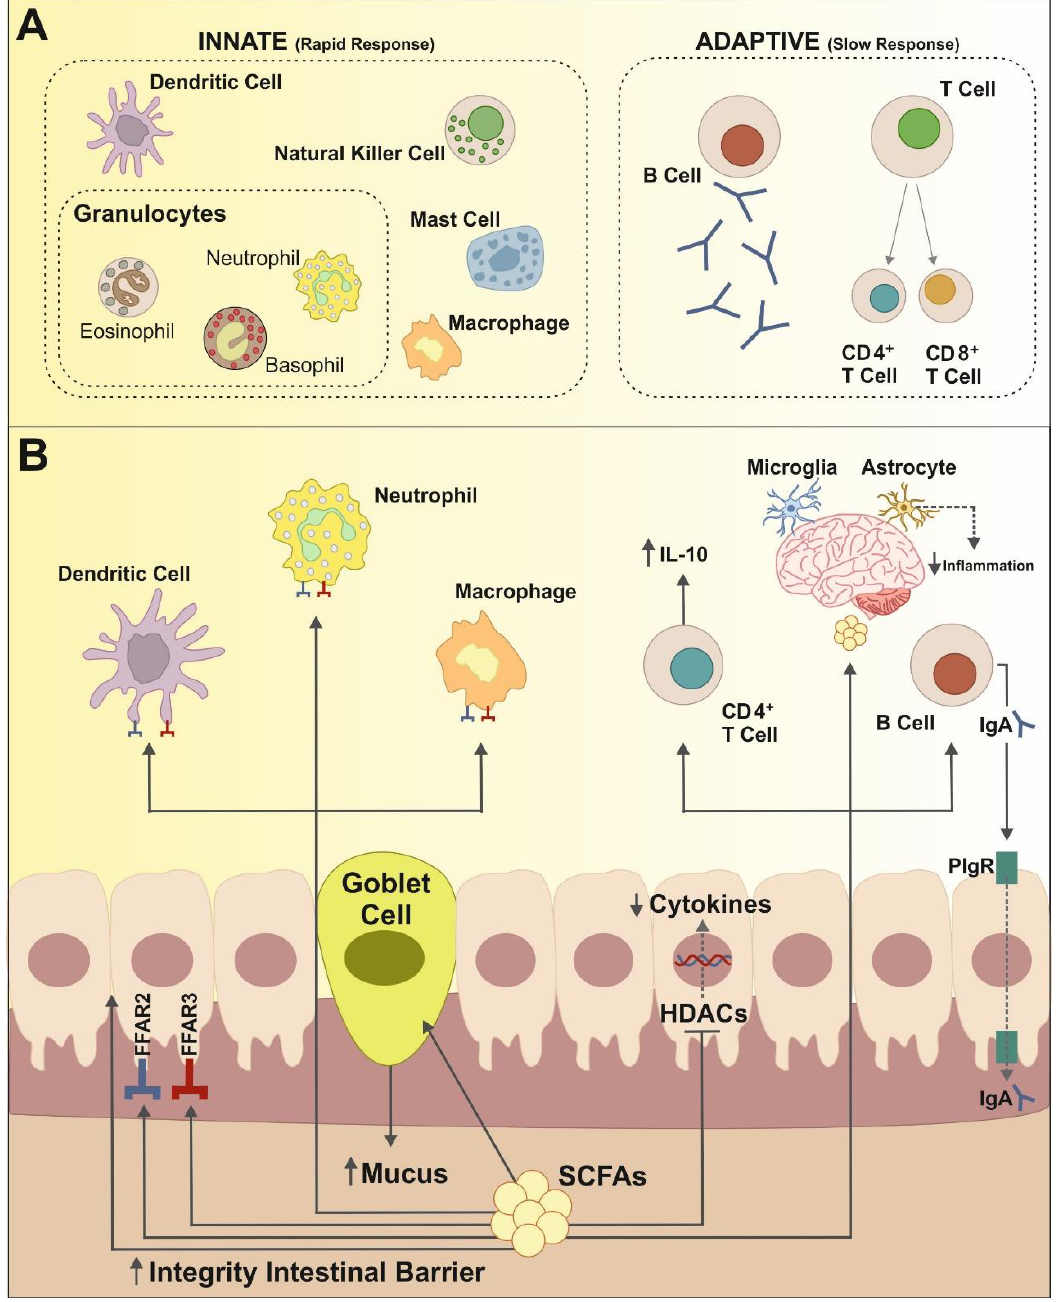
Figure 1. Relationships between the innate and the adaptive immune systems and gut microbiota. ( A ) The innate immune response is a very fast, pathogen-non-specific, first line of defense mechanism. It is mainly composed of macrophages, dendritic and natural killer cells, as well as different forms of granulocytes. The adaptive immune system is highly specific to a particular pathogen and is formed by B and T cells lymphocytes. ( B ) The gut microbiota is in close interaction with both the innate and the adaptive immune system. This interaction is frequently driven by SCFAs, which modulate local as well as systemic immune response. SCFAs can bind to G-protein-coupled receptors as FFAR2 and FFAR3 present on the surface of gut epithelial cells and immune cells including dendritic cells, macrophages and neutrophils, and are therefore important regulators of inflammatory response. SCFAs also promote the activation of B cells and the development of Treg CD4+T cells—for example, increasing secretion of IL-10 with important anti-inflammatory effects. Suppression of inflammatory factors like cytokines is further achieved by the inhibition of histone deacetylases (HDACs) activity. Finally, SCFAs have been shown to modulate immune inflammation responses in extraintestinal organs such as the brain, by acting on microglia and astrocytes.